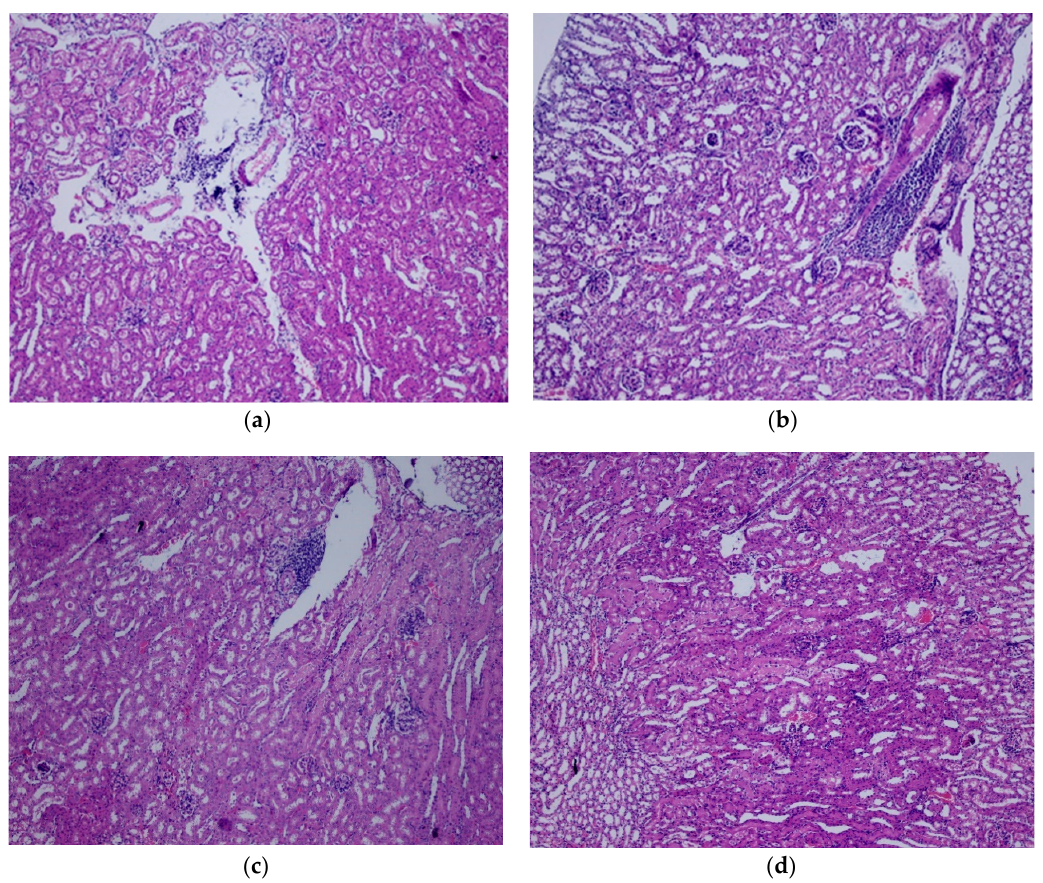
Figure 5. Renal tissue images of male and female mice that received a fixed dose of 2000 mg/kg BW and 5000 mg/kg BW of tocosh flour. (Stained with H&E, 200×). ( a ) Male group at the dose of 2000 mg/kg. Renal parenchyma with isolated chronic interstitial inflammatory infiltrate. ( b ) Female group at the dose of 2000 mg/kg. Renal parenchyma showing mild chronic interstitial inflammatory infiltrate with a tendency to lymphoid accumulation. ( c ) Male group at the dose of 5000 mg/kg. Renal parenchyma showing mild chronic interstitial inflammatory infiltrate with a tendency to the formation of lymphoid accumulation. ( d ) Female group at the dose of 5000 mg/kg. Renal parenchyma with isolated chronic interstitial inflammatory infiltrate.